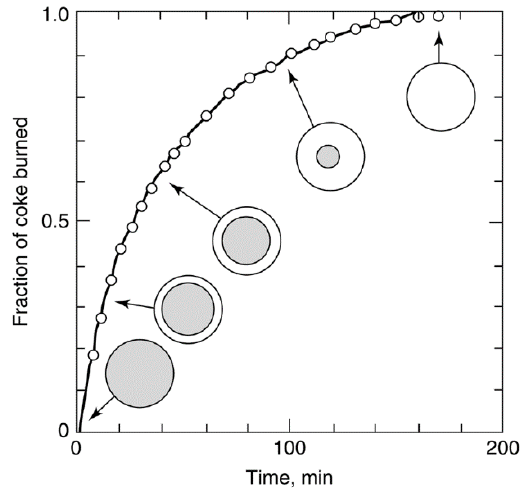
Figure 36. Shell-progressive regeneration of fouled pellet Reproduced from